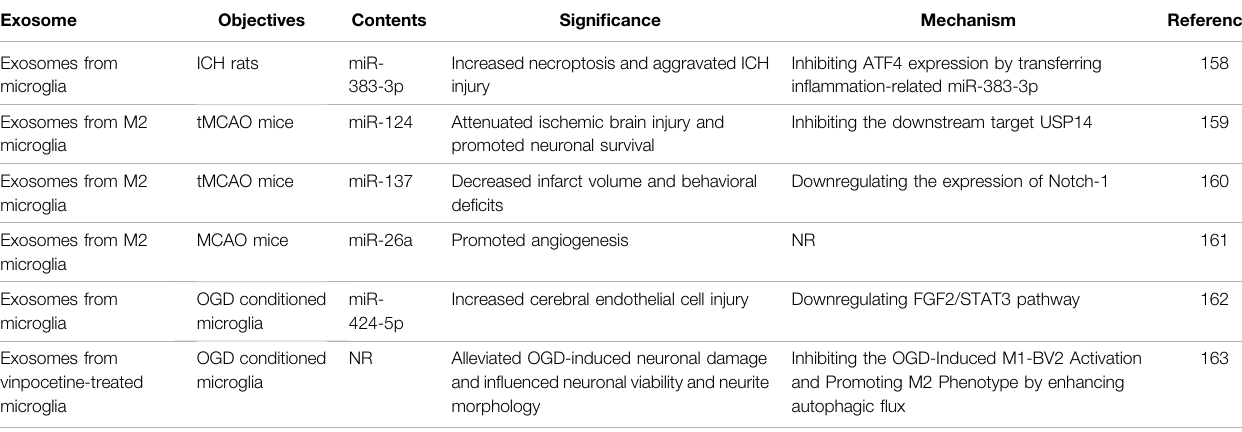
TABLE 2 | Roles of exosomes derived from polarized microglia in stroke treatment.